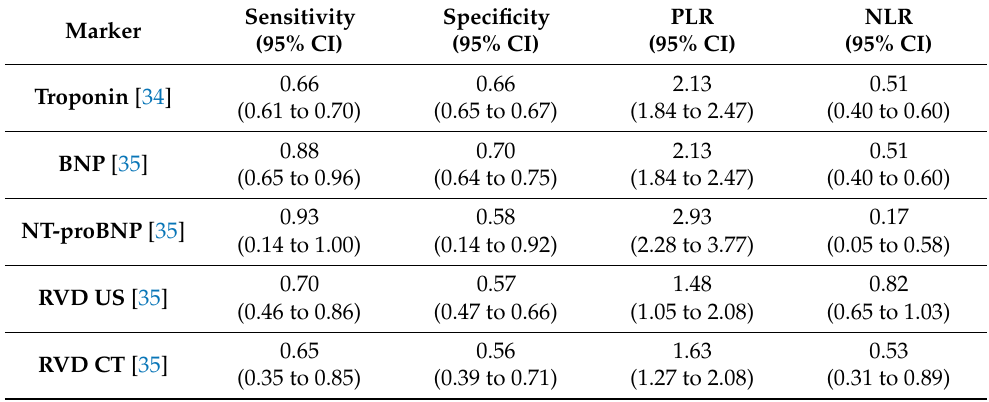
Table 3. Prognostic value of markers of right ventricular dysfunction for short-term mortality.